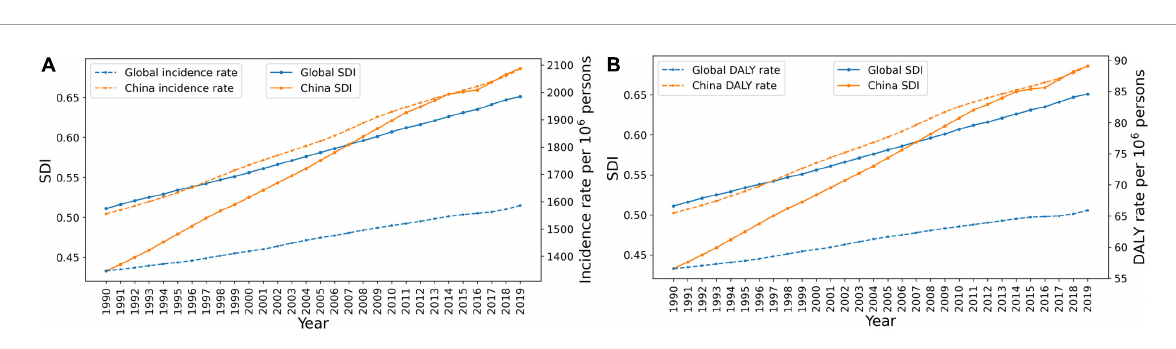
non-industrialized areas than in modernized populations (20). Possible reasons for this include differential access to healthcare, differential socioeconomic status of patients, and cultural perceptions of skincare and beauty as well as dietary habits and lifestyle. In addition, underdiagnosis may contribute to the lower prevalence of acne in